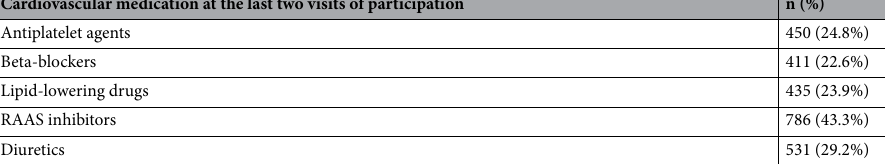
Table 4. Numbers of patients with constant cardiovascular medication at the last two study visits. RAAS = Renin–angiotensin–aldosterone system. For details see Methods. Percentages refer to the total study population (n =